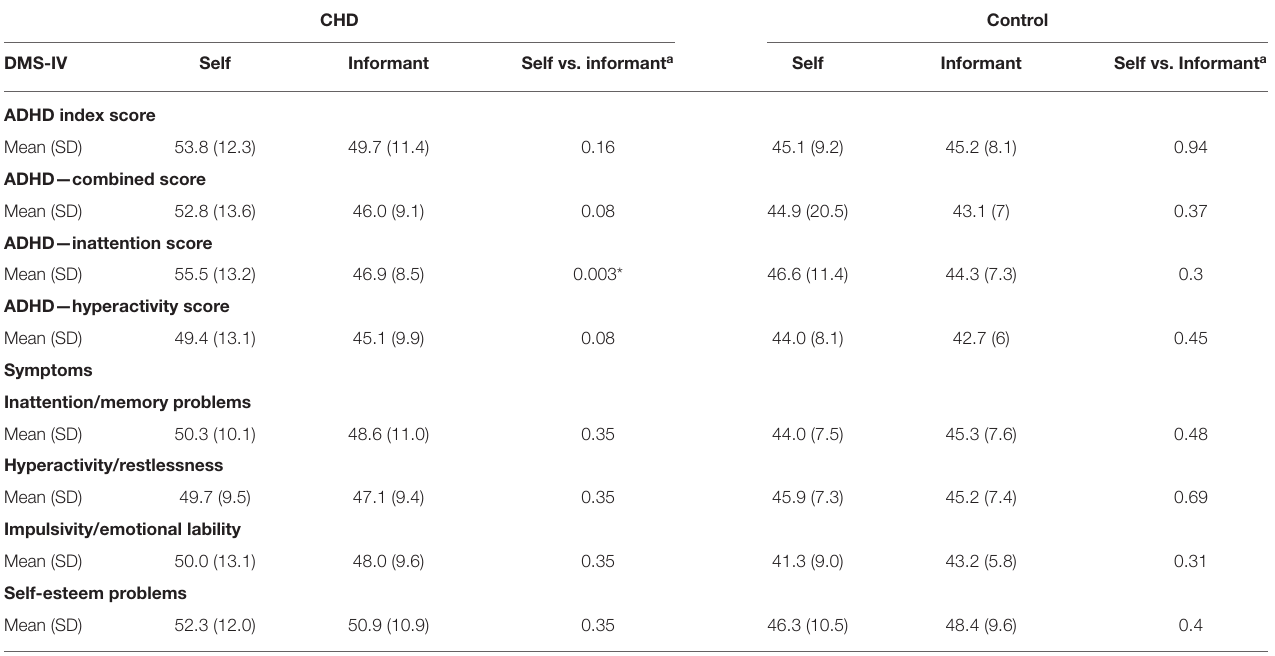
TABLE 4 | Congenital heart defect informant vs. congenital heart defect self-evaluation (mean and SD of T-scores). CHD Control Informant Self vs. informant a Self Informant Self vs. Informant